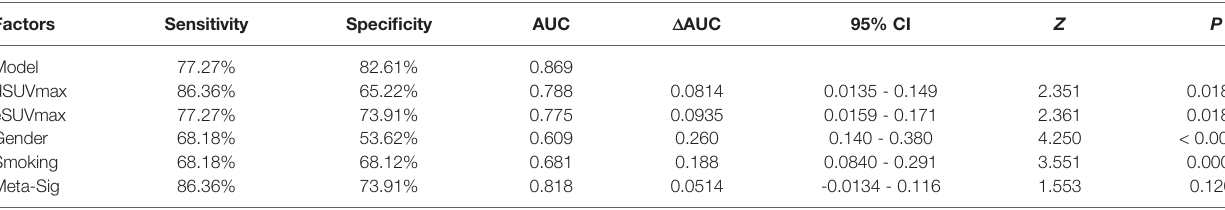
TABLE 3 | Performance of the combined model and other factors according to TMIT I tumors. Factors